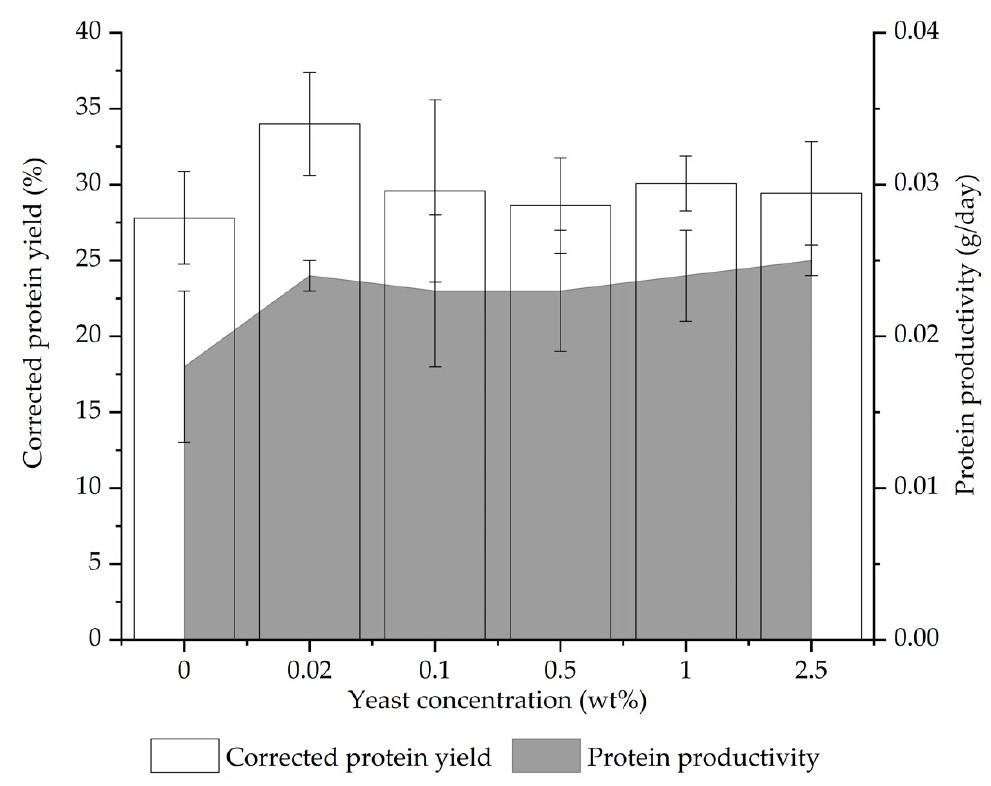
Figure 2. Impact of di ff erent yeast concentrations inoculating CEW on corrected protein yields and protein productivities from BSFL.